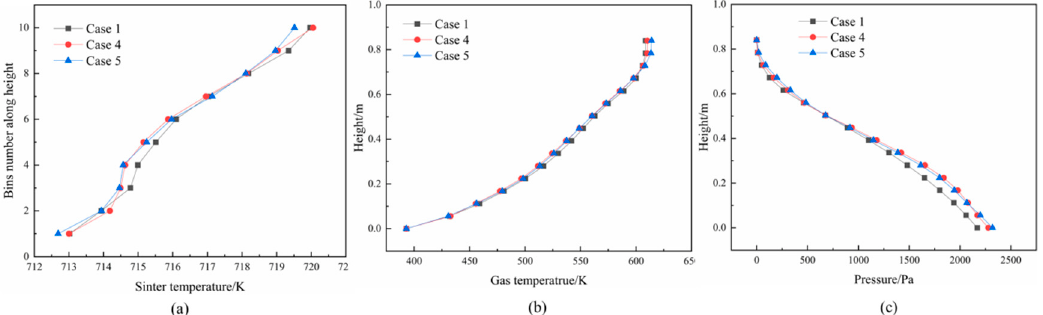
Figure 9. Distribution of sinter temperature, cooling gas temperature and cooling gas pressure for Cases 1,4 and 5. ( a ) Sinter temperature distribution; ( b ) gas temperature distribution; ( c ) cooling gas pressure distribution.